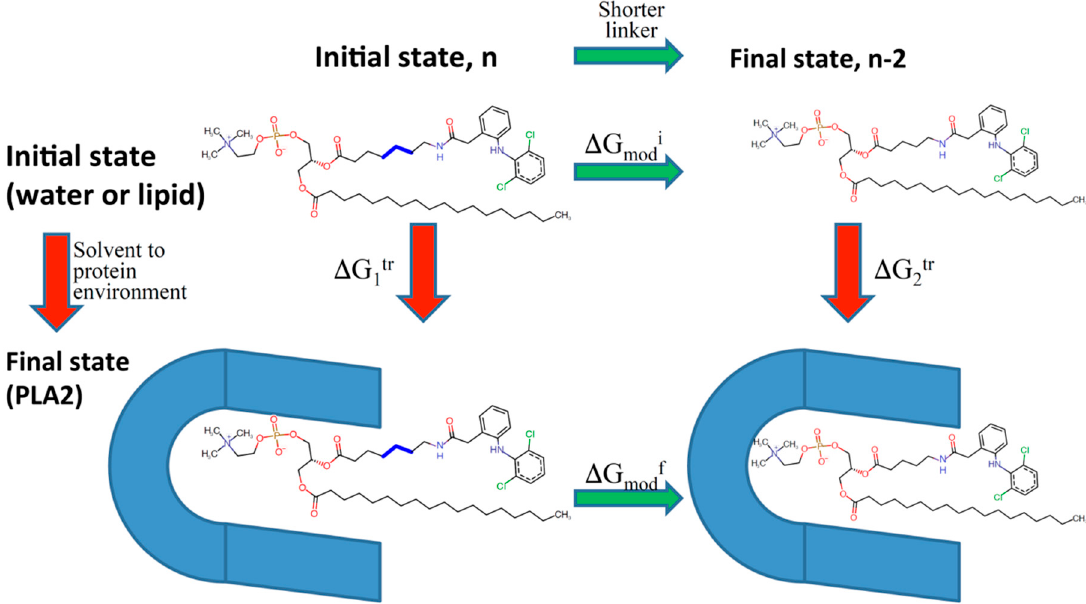
Figure 7. Thermodynamic cycle diagram used in the computational modeling of relative binding free energy of PL-diclofenac conjugates to the PLA 2 enzyme, using the difference between the final state (conjugate in PLA 2 , ∆ G modf ) and the initial state free energy (conjugate in water/lipid, ∆ G modi ) . ∆ G 1tr and ∆ G 2tr represent free energies of adding/removing –CH 2 units from the linker. Reproduced with permission from reference [50], Springer Nature, 2017.